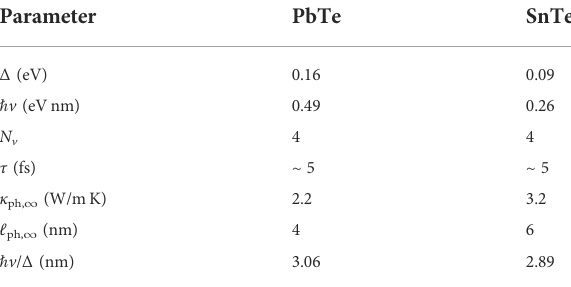
TABLE 1 Model parameters for PbTe and SnTe, obtained from Refs. [27, 45, 46].